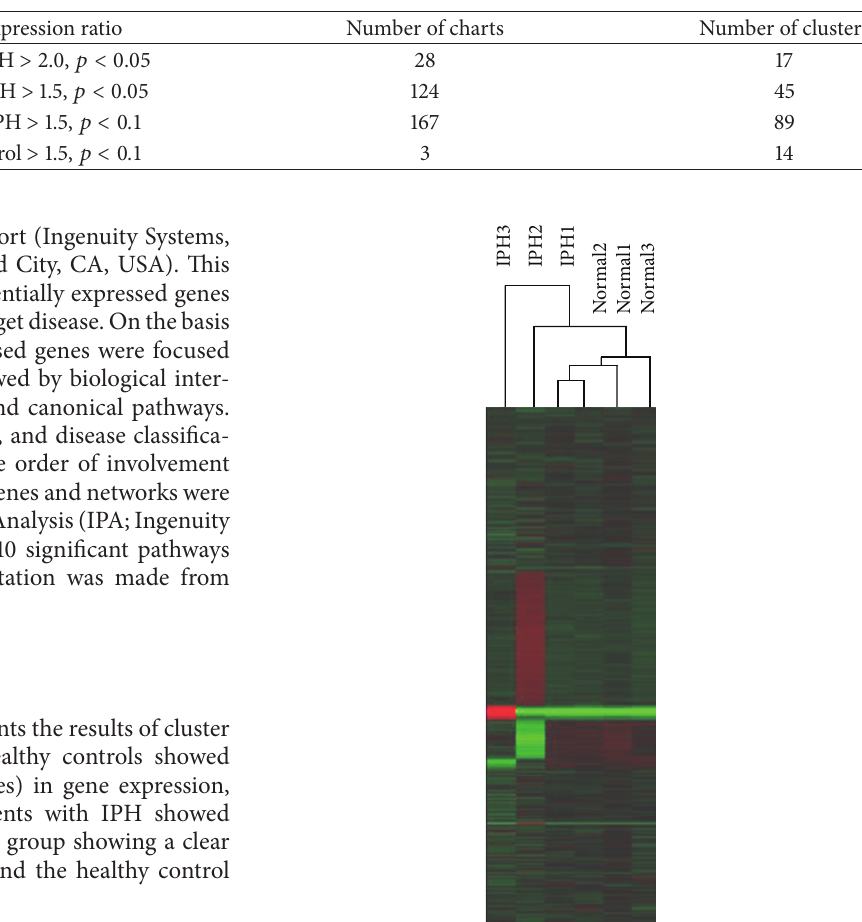
Table 1: Number of charts and clusters extracted by functional annotation analysis.